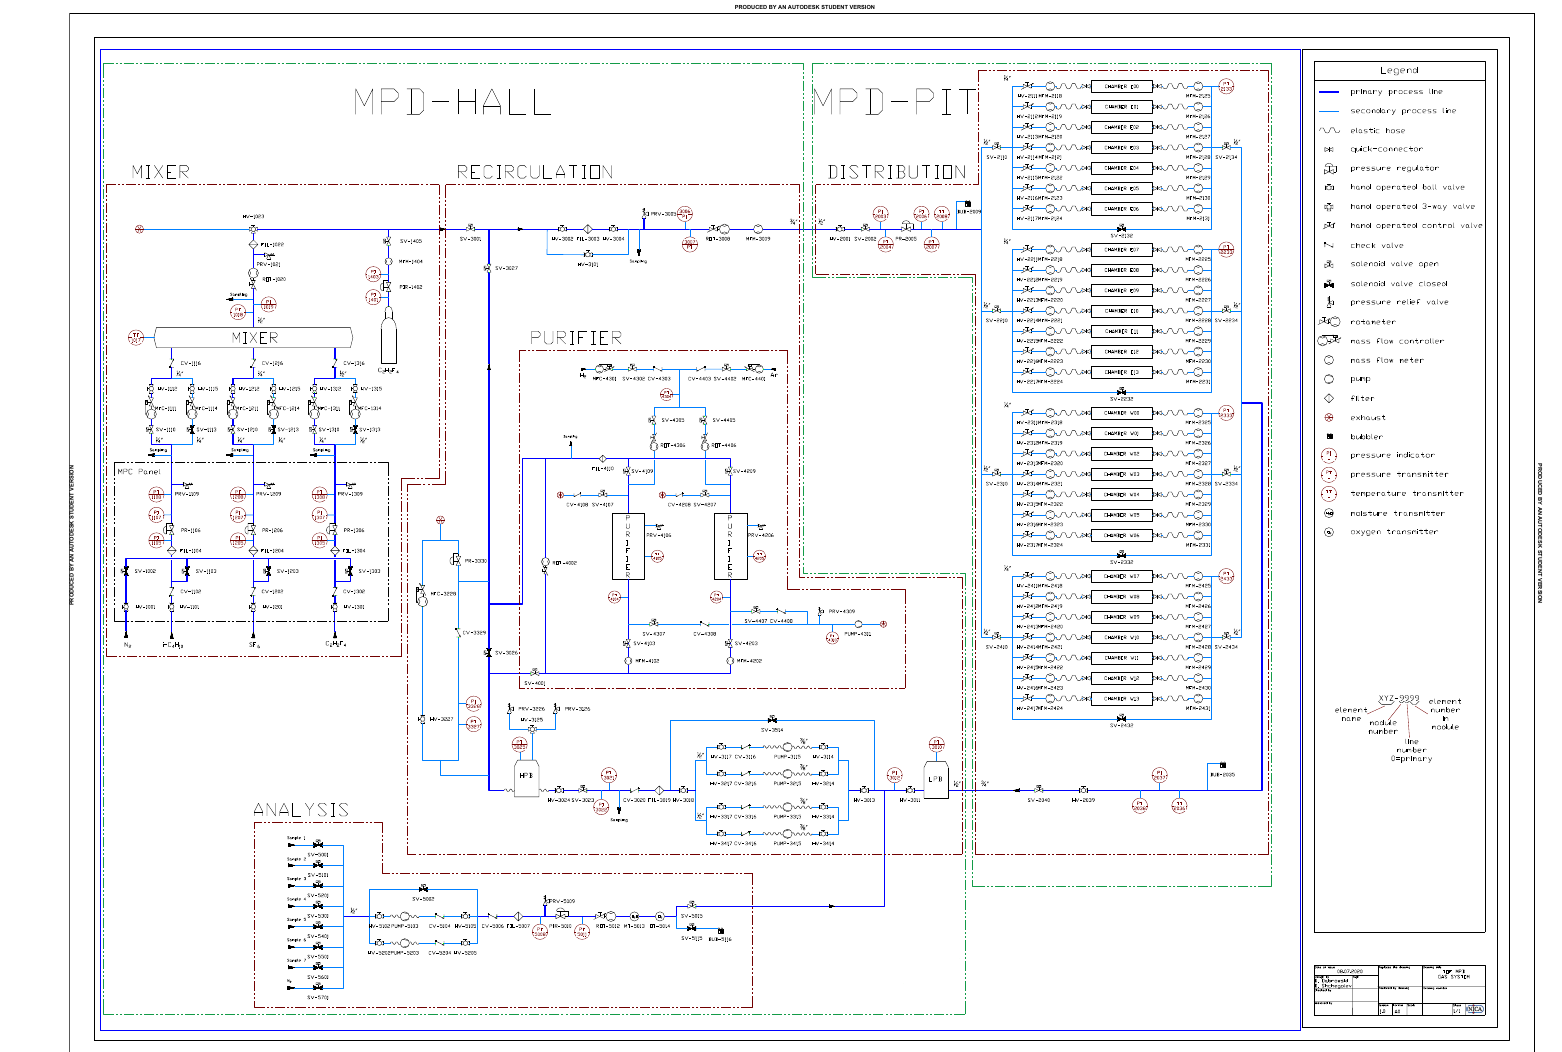
Figure A1. P&ID diagram of the target system